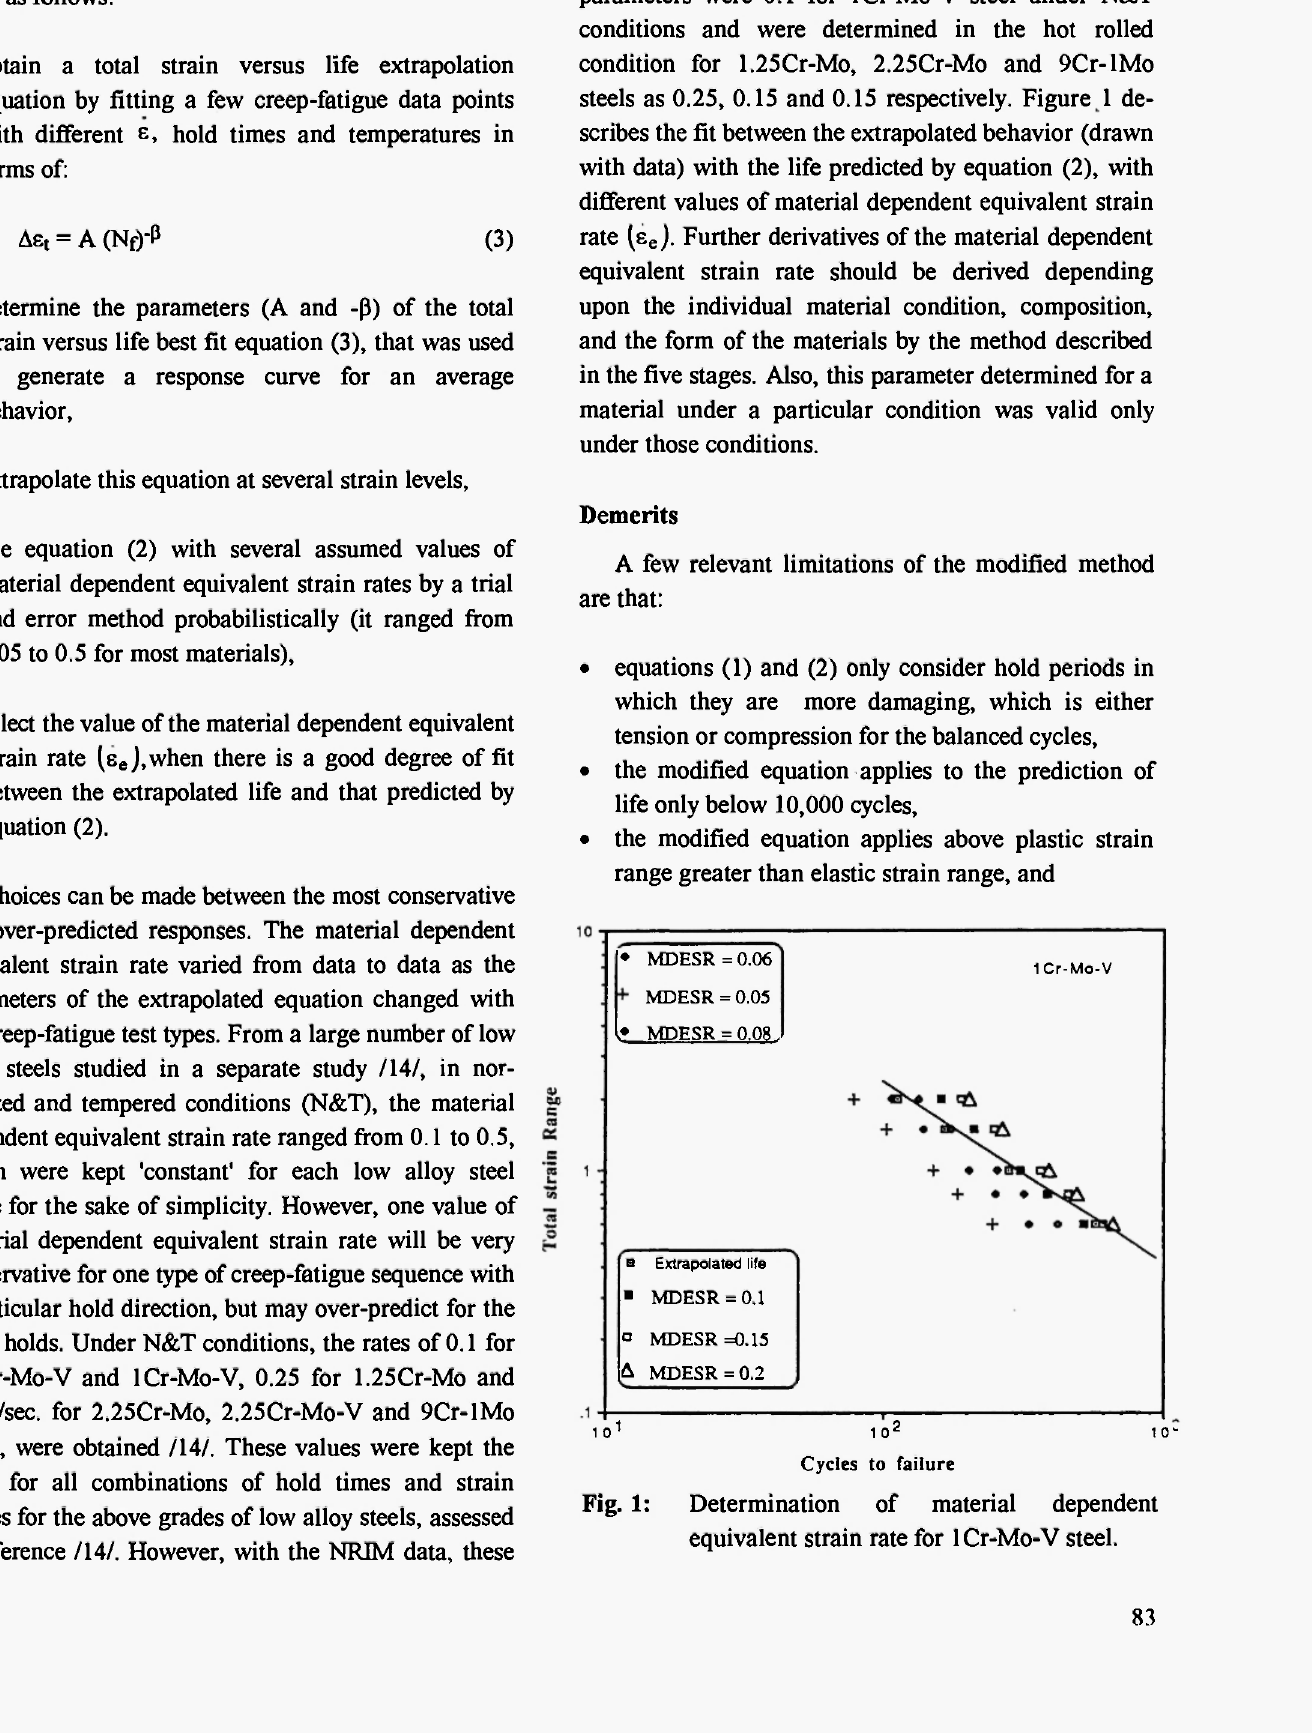
Fig. 1: Determination of material dependent equivalent strain rate for lCr-Mo-V